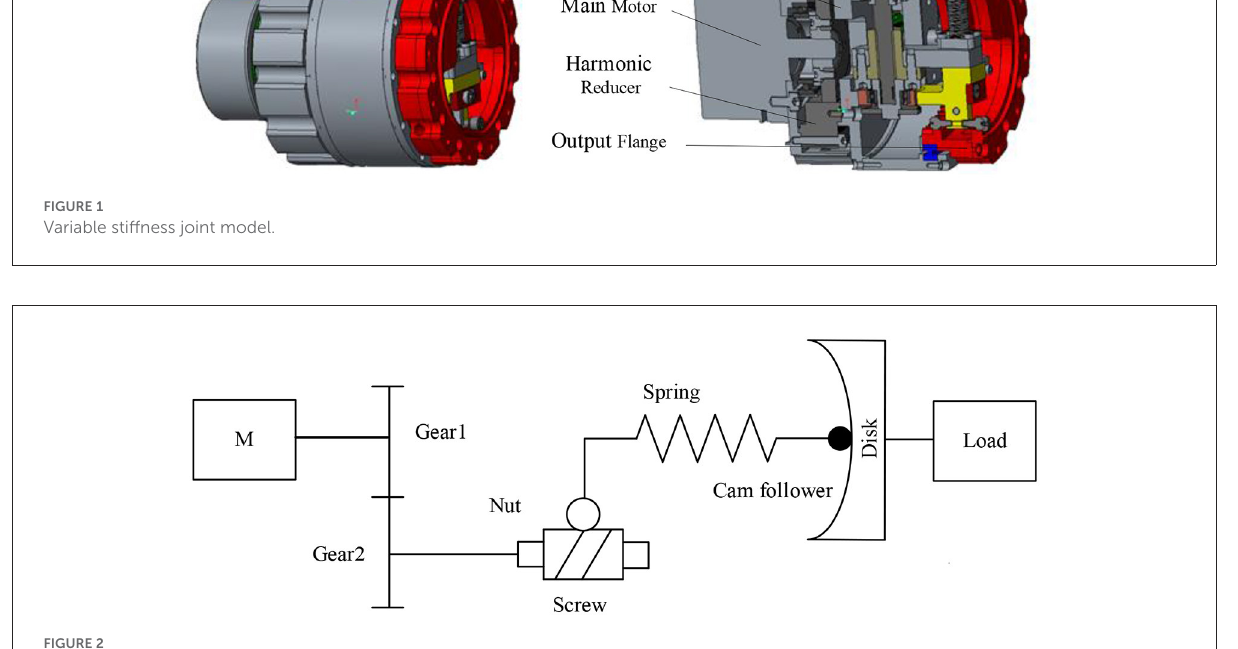
FIGURE2 Schematic diagram of variable stiffness module